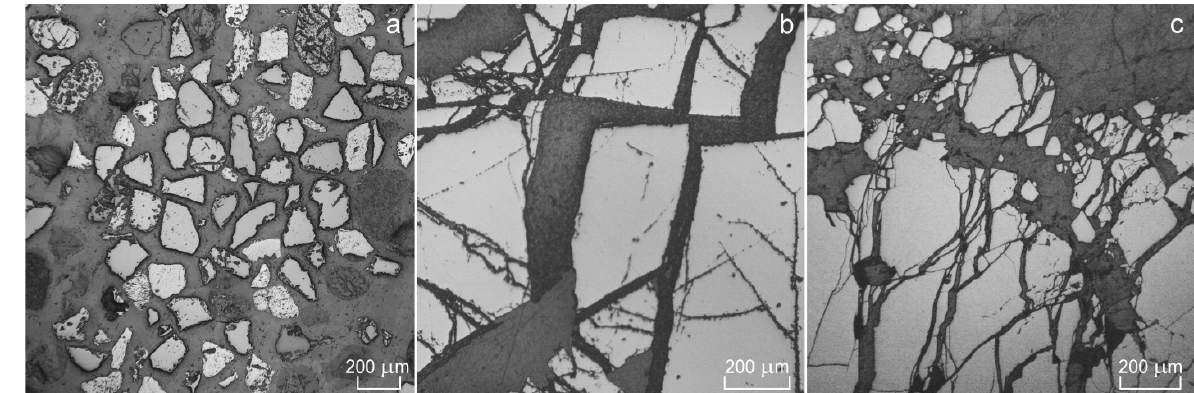
Figure 16. Optical images (reflected light) of Sabantuy chromite sandstone ( a ) and Kraka chromitites: ( b )—Shatran mine, ( c )—Bolshoy Bashart mine.